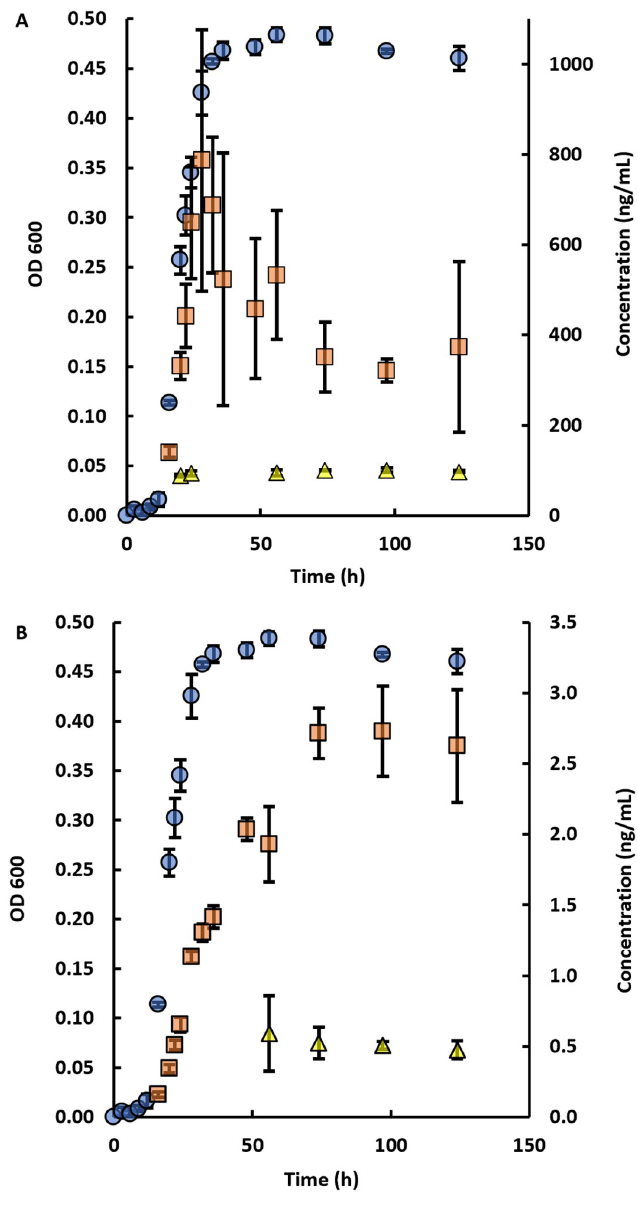
Fig 5. Growth curves showing the OD 600 and production of N-HLs with respect to time in P . atrosepticum . (A) D,L-O-C6 and (B) D,L-H-C6-HLs. Average of triplicates shown with standard deviations as error bars. Blue circle indicates the OD 600 reading with the measured values in the left y-axis. Red Square indicates the concentration of L-O-C6 (A) and L-H-C6 (B) with measured values in the right y-axis. Yellow triangle indicates the concentration of D-O-C6 (A) and D-H-C6 (B) with measured values in the right y-axis. Concentrations of D-O-C6 was increased by 100 times for